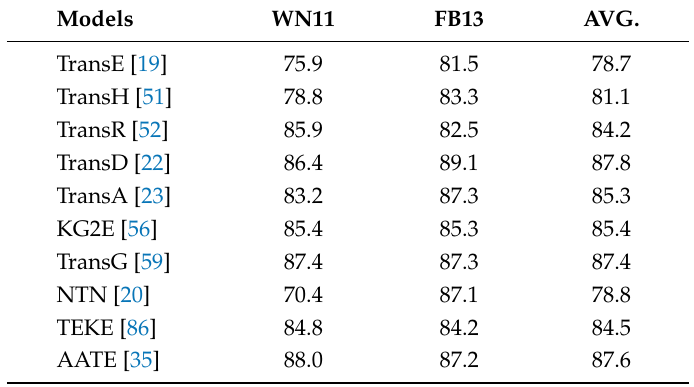
Table 7. Evaluation results on triplets classification accuracy (%) for different embedding